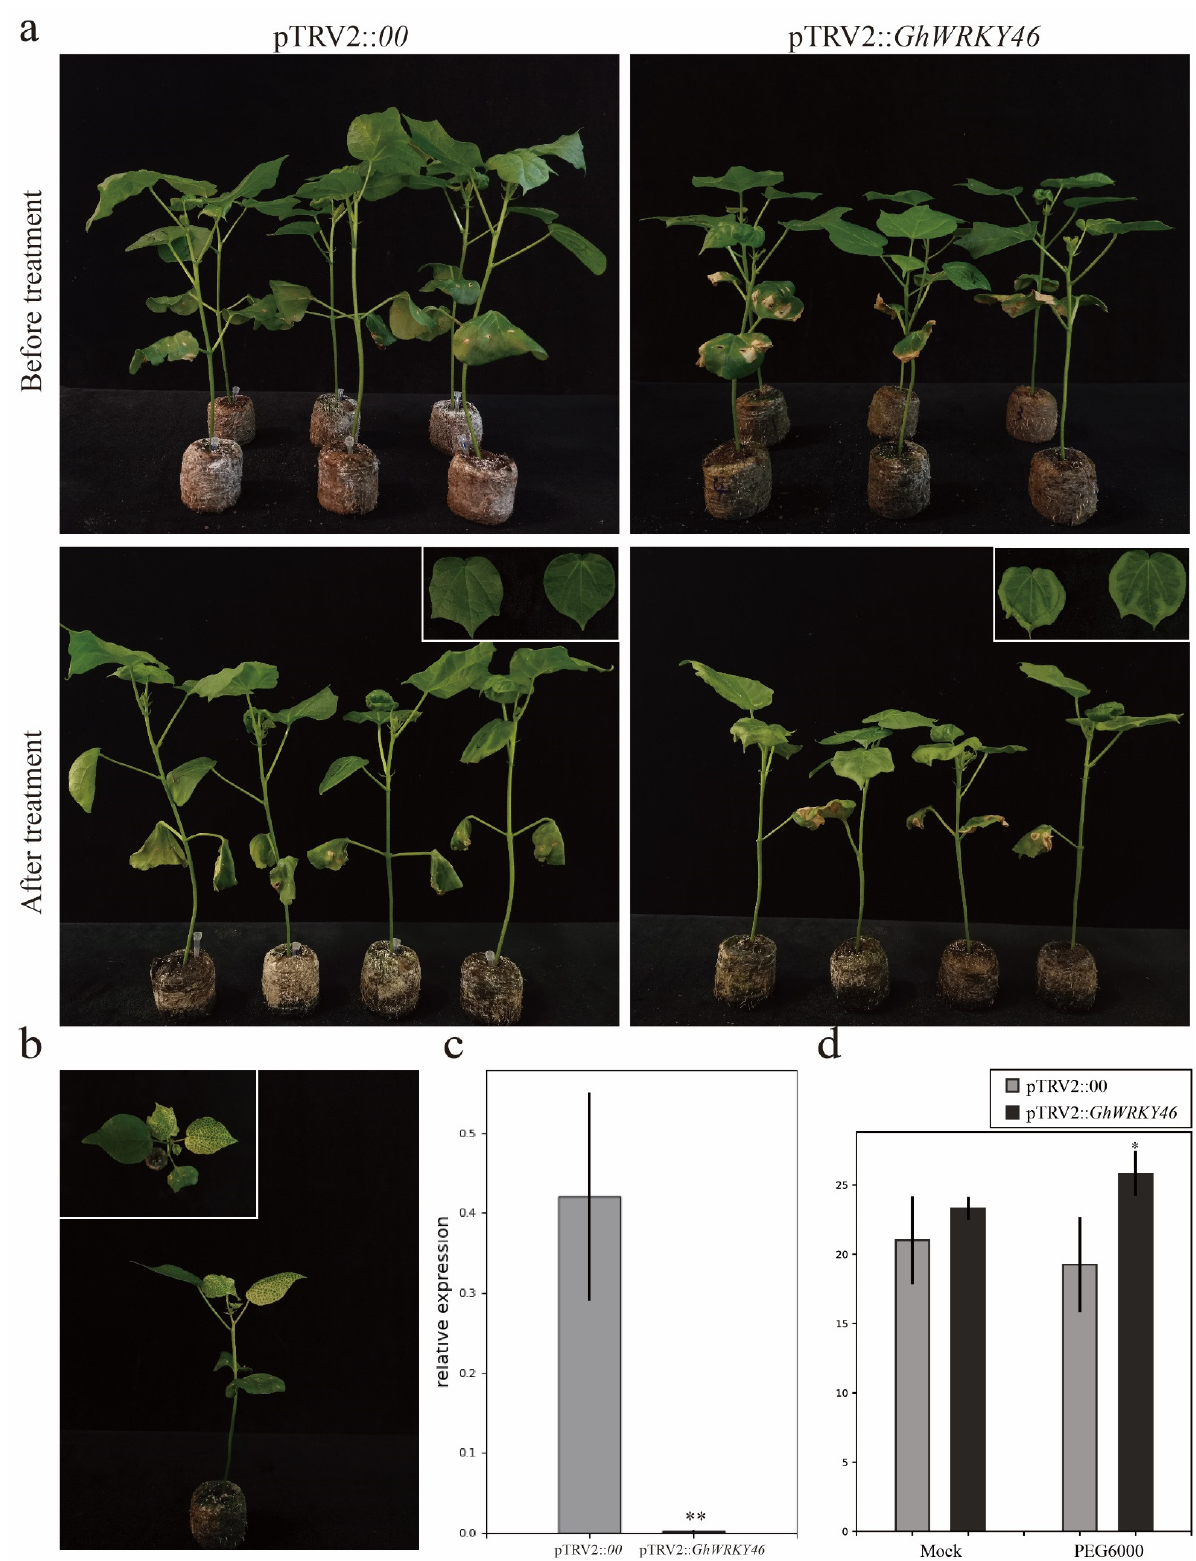
Figure 8. Silencing GhWRKY46 via VIGS decreases PEG6000 tolerance in cotton. ( a ), Phenotype of pTRV2:: GhWRKY46 plants under PEG6000 treatment. ( b ), Albino phenotype after pTRV2:: CLA1 silencing. ( c ), Relative expression of GhWRKY46 in pTRV2:: 00 and silencing pTRV2:: GhWRKY46 plants via qRT-PCR analysis. ( d ), The MDA content of pTRV2:: 00 and pTRV2:: GhWRKY46 after salinity stress. Error bars represent the standard deviation of three independent biological replicates (* p < 0.05, ** p < 0.01 Student’s t